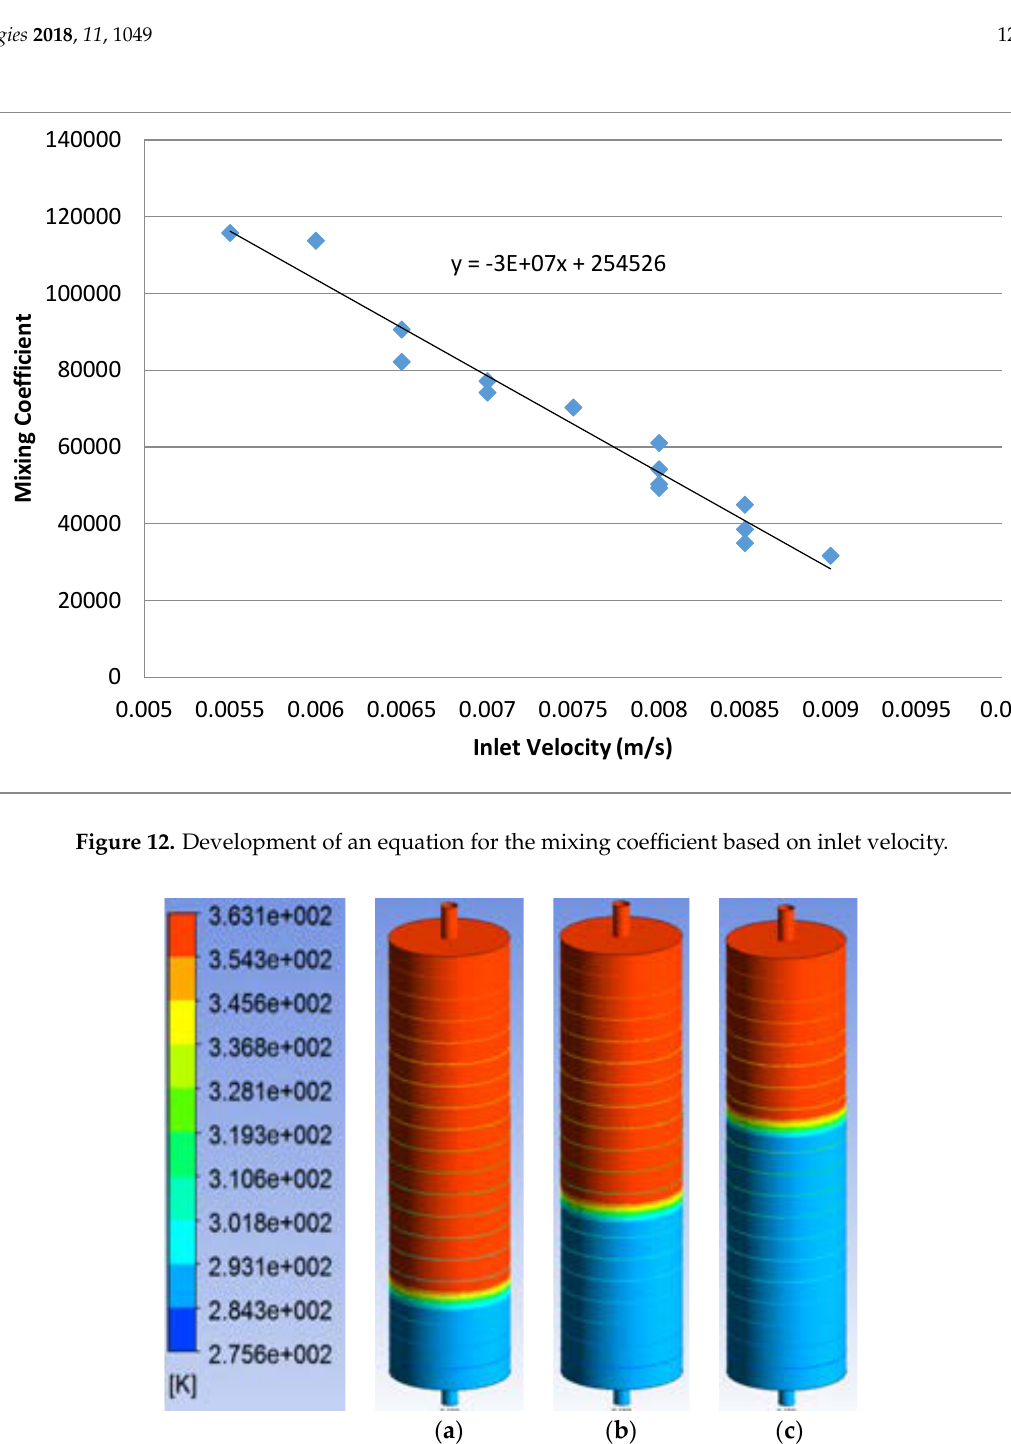
Figure 13. TES-1 at 90 °C, 2.0 cm/s: ( a ) 400 s; ( b ) 800 s; ( c ) 1200 s.